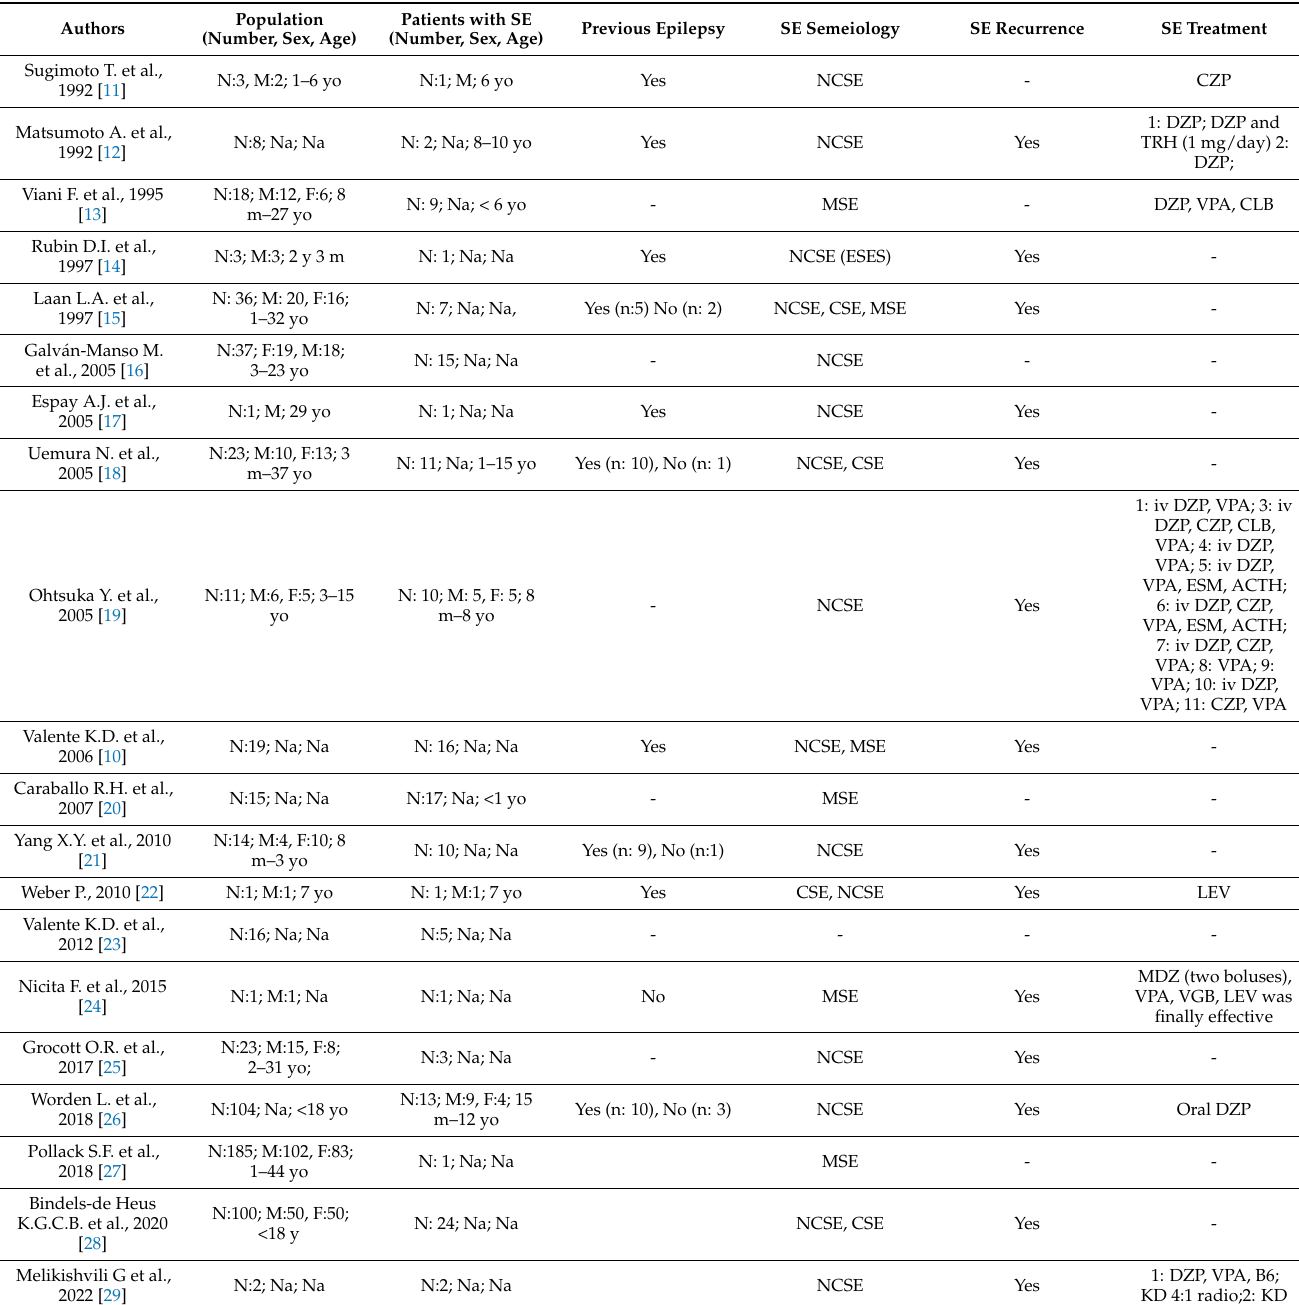
Table 2. Status Epilepticus in Angelman